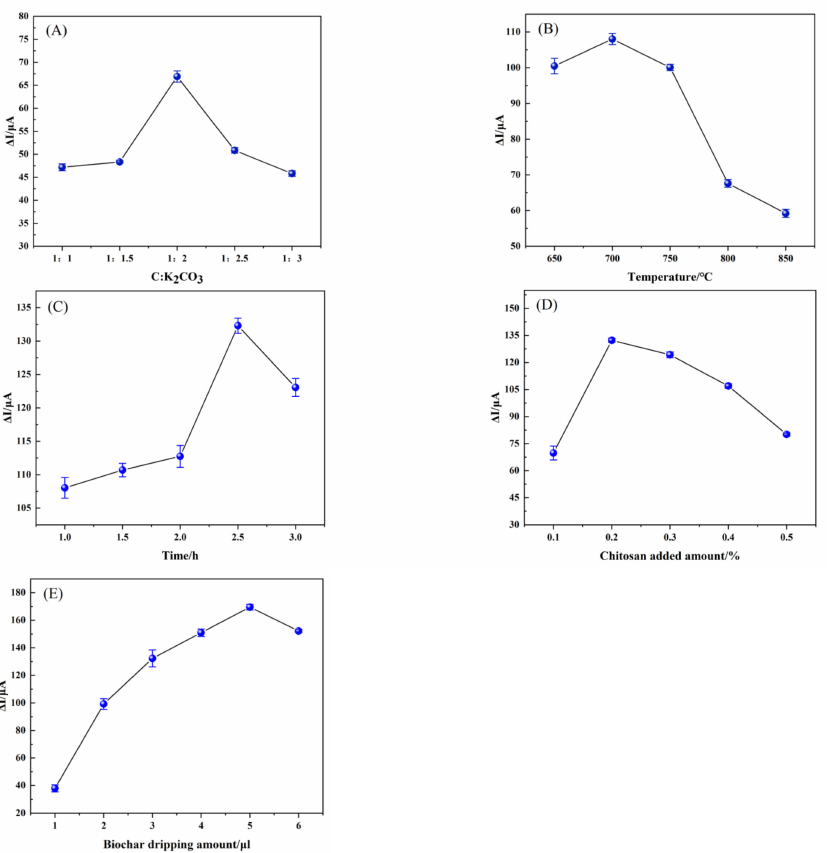
Figure 6. The plots for the relationship of ( A ) the ratio of biochar and activator, ( B ) the firing temperature of TBC, ( C ) the roasting time of TBC, ( D ) chitosan addition amount and ( E ) TBC dripping amount on the current difference ( ∆ I) by CV in 5 mmol · L − 1 [Fe (CN) 6 ] 3–/4 − (1.0 mol · L − 1